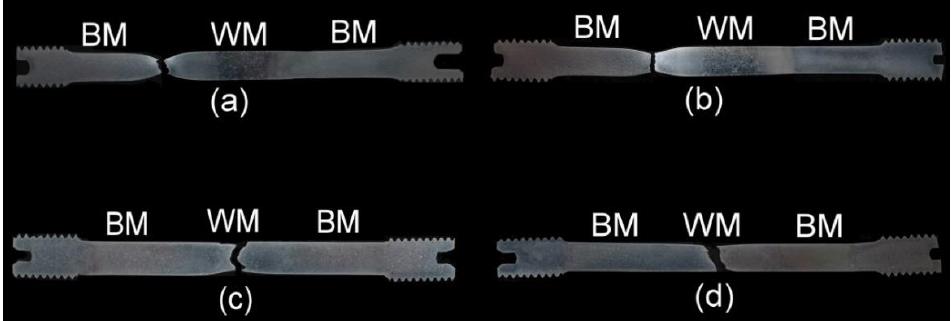
Figure 12. Photo-macrographs of fractured tensile samples’ counterparts indicating various failure locations after room-temperature tensile tests of T92/T92 weldments in their individual material states: ( a ) “PWHT-1”; ( b ) “PWHT-1 + hydrogen”; ( c ) “PWHT-2”; ( d ) “PWHT-2 + hydrogen”.